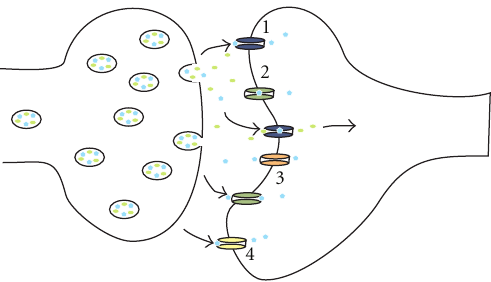
Figure 1: Multiple mechanisms for zinc uptake following synaptic release. Zinc and glutamate are released from a “gluzincergic” synapse during neurotransmission. The actions of glutamate, alongside membrane depolarisation, open a number of zinc- permeable channels on the postsynaptic membrane which clear the ion from the extracellular fluid. (1) AMPA receptors; (2) NMDA receptors; (3) voltage-gated calcium channels; (4) TRPM7. (blue pentagons) zinc ion and (green ellipses) glutamate molecule. For simplicity, zinc-permeable channels are only shown on the post- synaptic